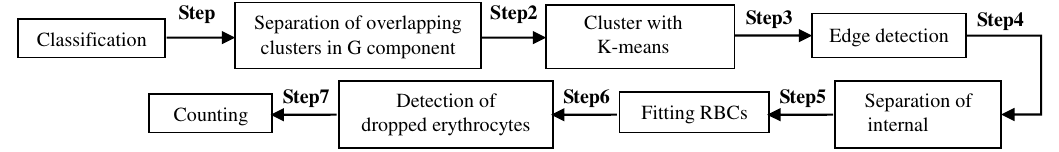
Fig. 7. The °owchart of counting.